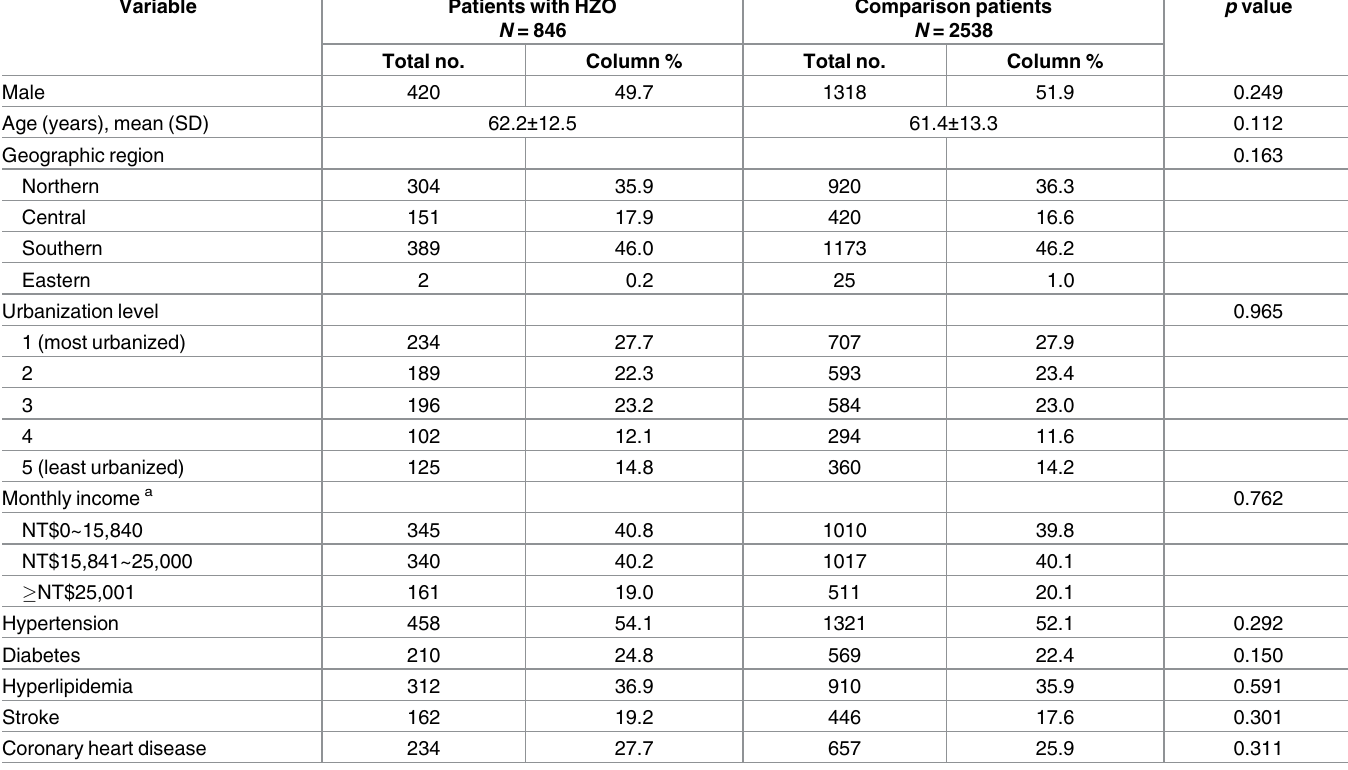
Table 1. Demographic characteristics of sampled patients in Taiwan, stratified by the presenceof herpes zoster ophthalmicus (HZO) (N = 3384). Variable